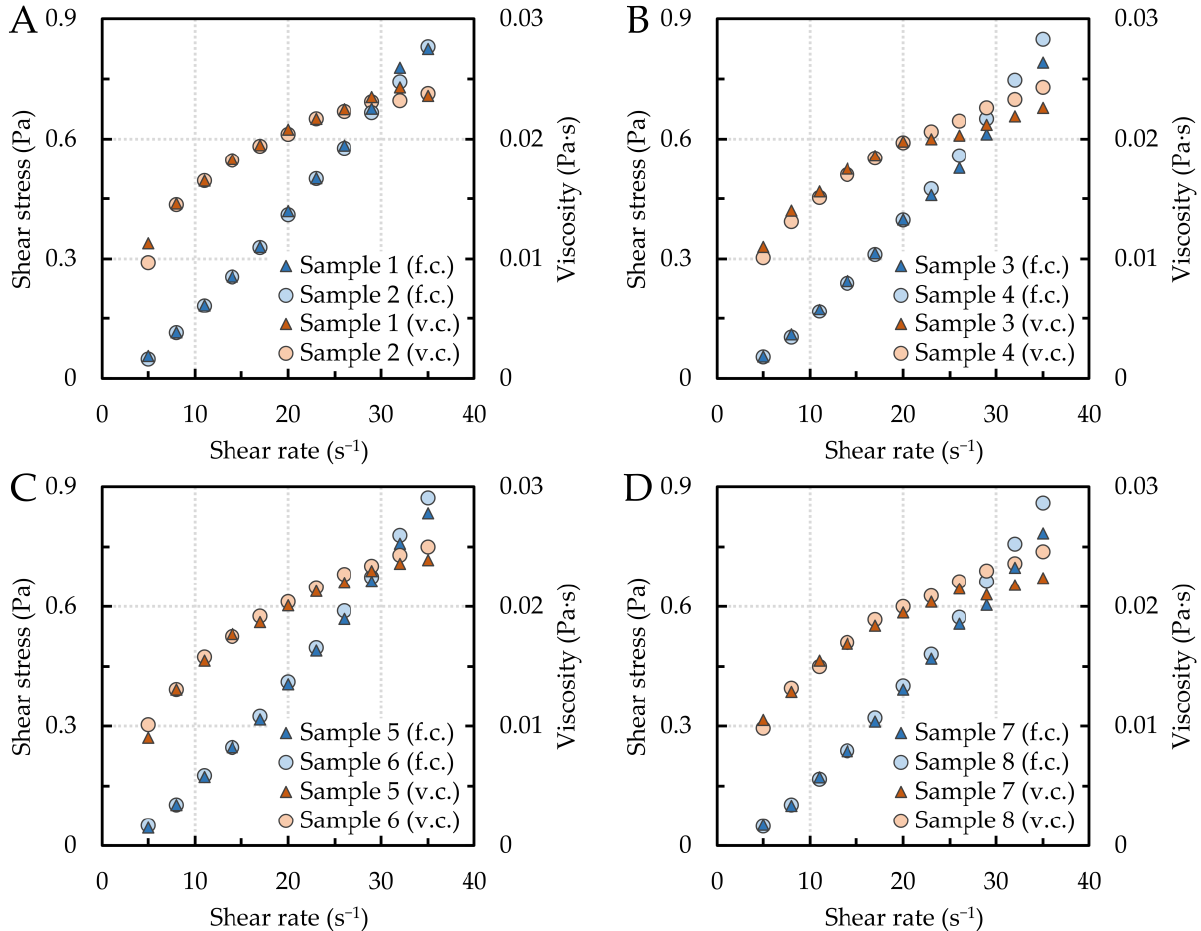
Figure 1. Flow (f.c.) and viscosity (v.c.) curves for samples ( A ) 1 and 2, ( B ) 3 and 4, ( C ) 5 and 6, and ( D ) 7 and 8.